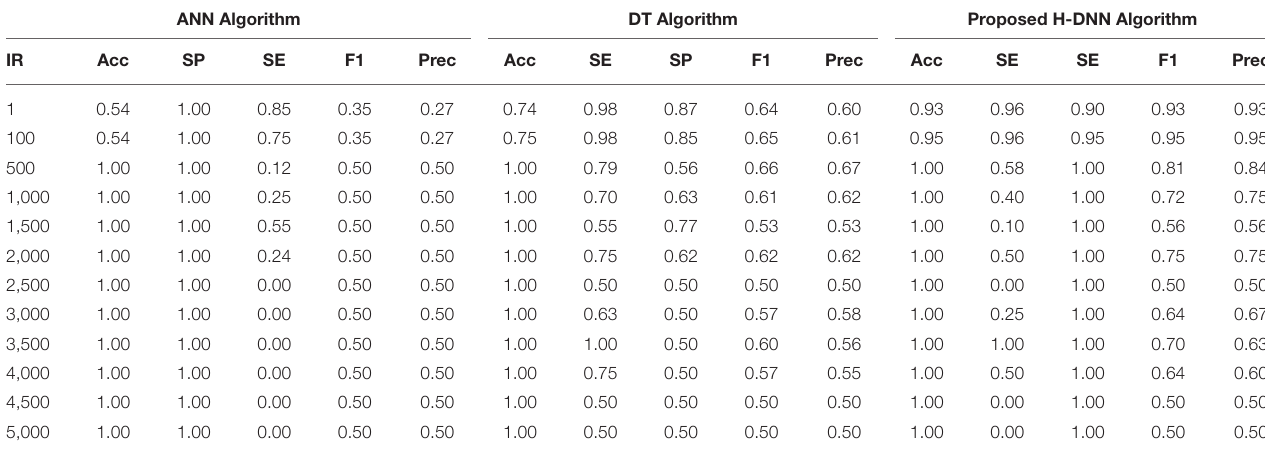
TABLE 7 | ANN and DT results using arabidopsis dataset.